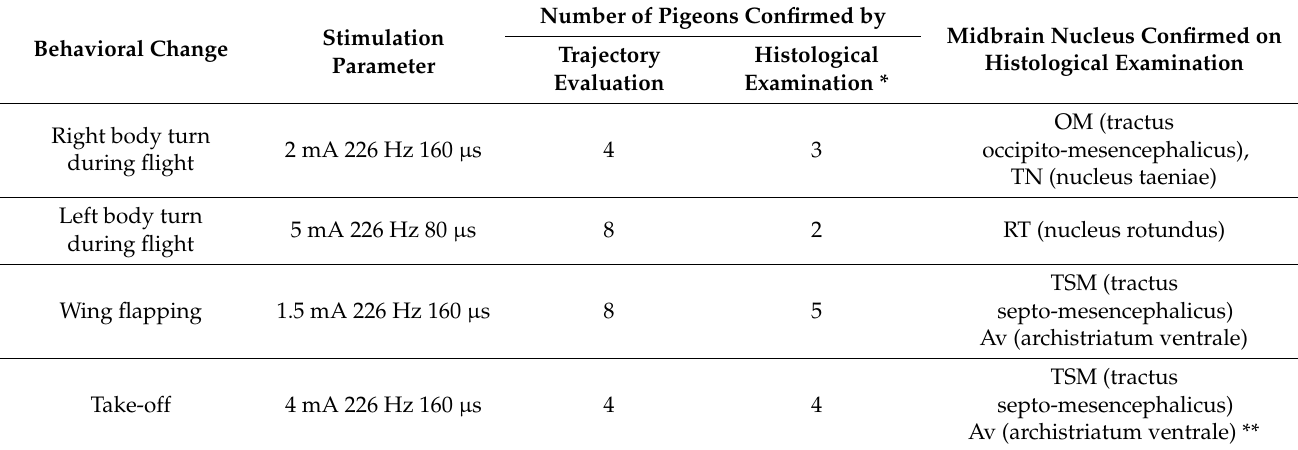
Table 1. Functions of cerebral nuclei were confirmed by the behavioral evaluation and the histological examination. Number of Pigeons Confirmed by Midbrain Nucleus Confirmed on Stimulation Behavioral Change Histological Histological ExaminationTrajectory Parameter Evaluation Examination * Right body